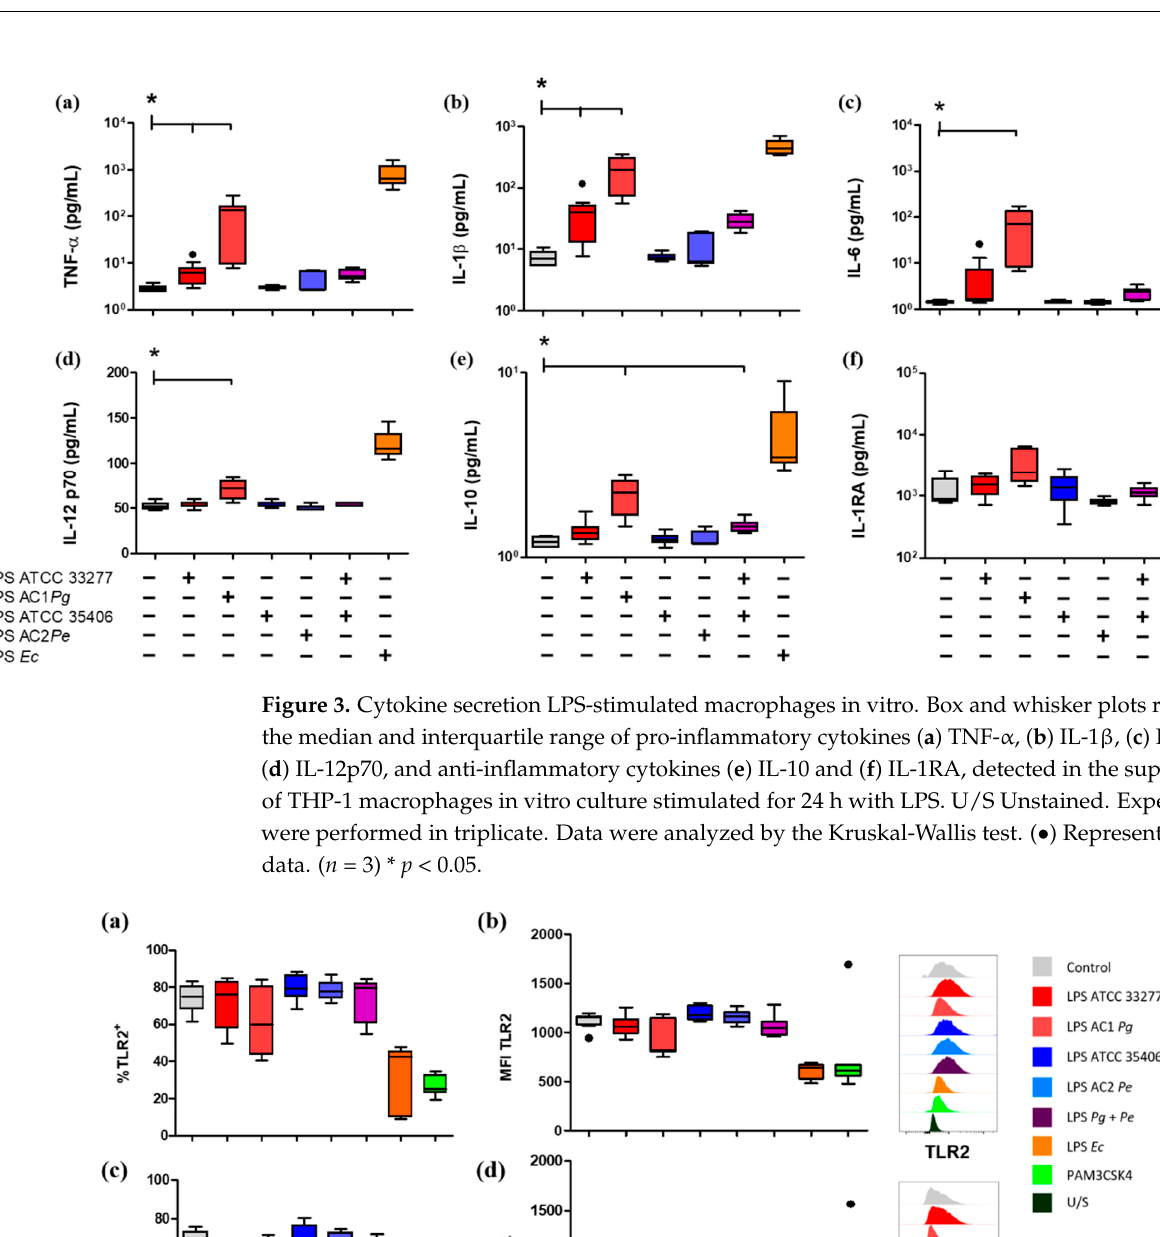
Table 1. Spearman’s correlation matrix of M1 and M2 surface markers, TLR2, TLR4, and secreted cytokines levels.